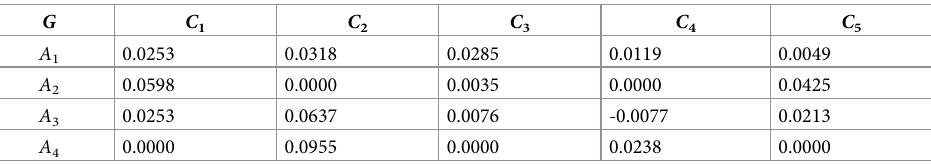
ffiffiffi p 3 � 1 : 386 .